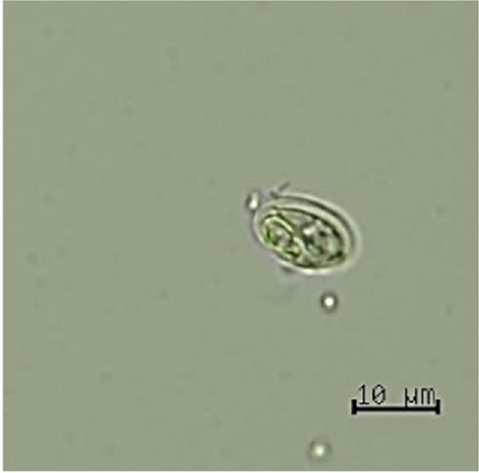
Figure 1. Cyst of Giardia duodenalis in prairie dog fecal sample.